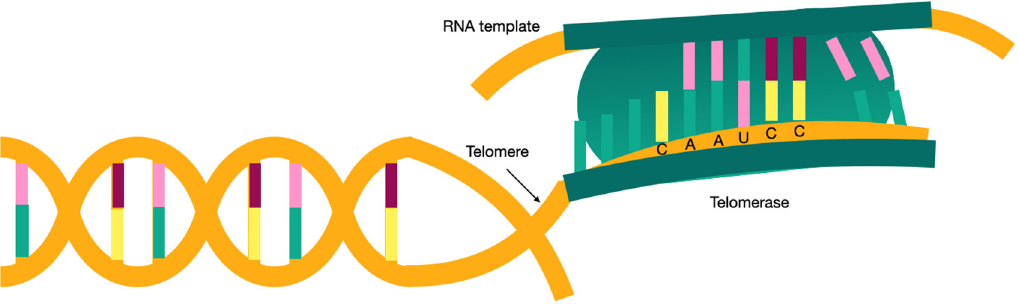
Figure 1. Figure 1. Telomerase.